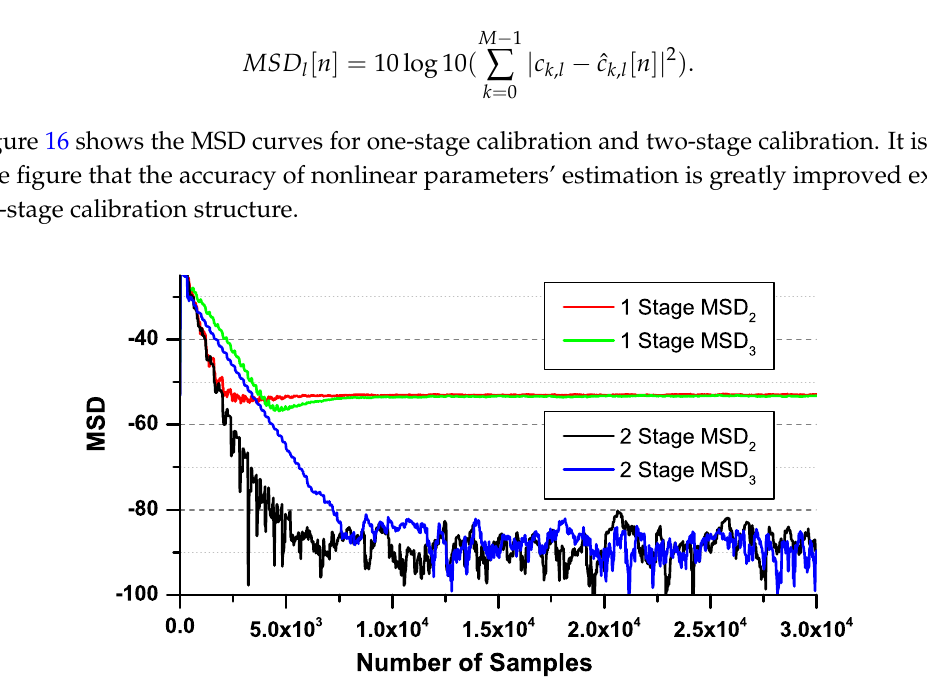
Figure 16. The mean square deviation (MSD) of one-stage calibration and two-stage